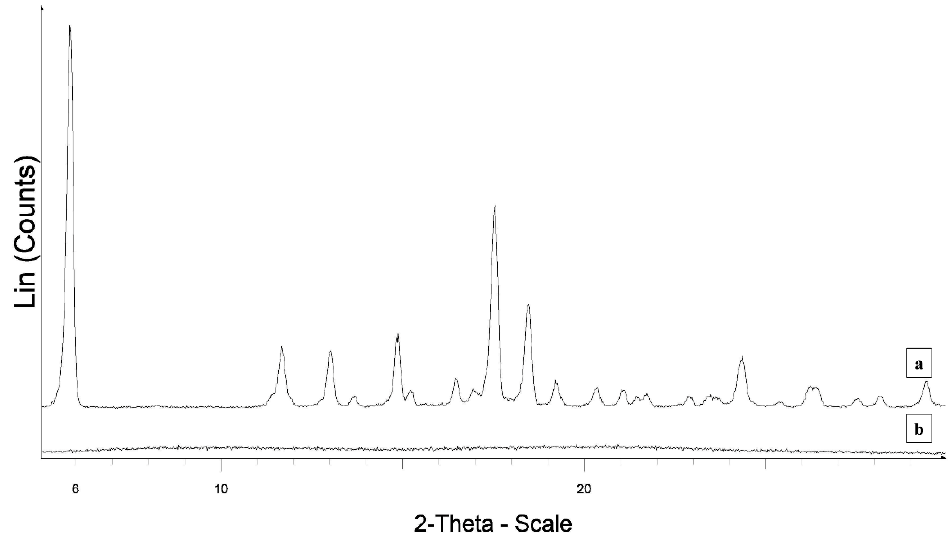
Figure 4. XRPD patterns of carvedilol (a) and CFb4 (b).